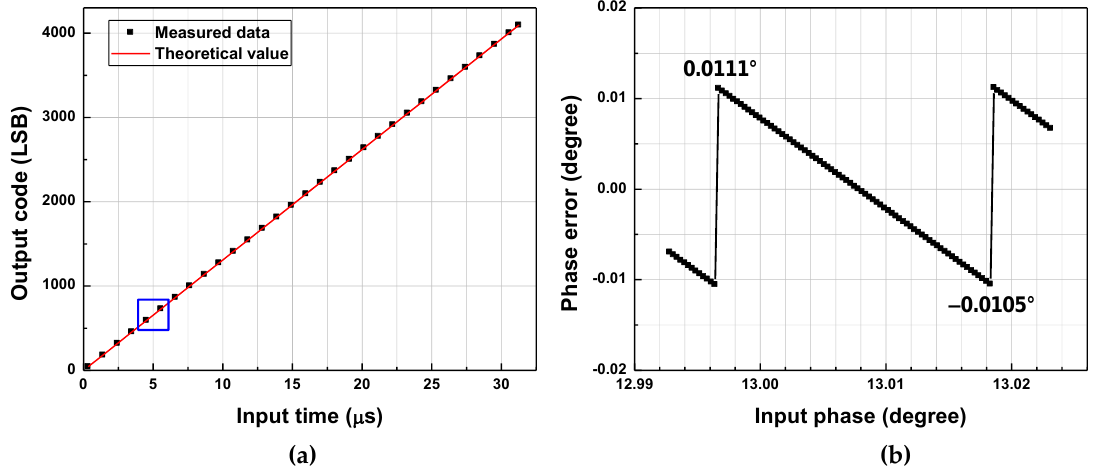
Figure 12. (a) Measured input-output characteristic of TDC, and (b) phase errors for f in = 8 kHz.